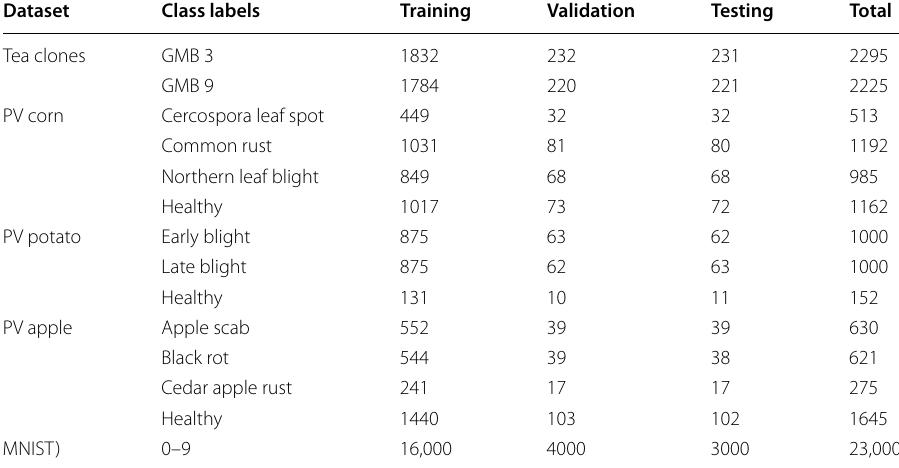
Table 1 The data distribution in the experiments